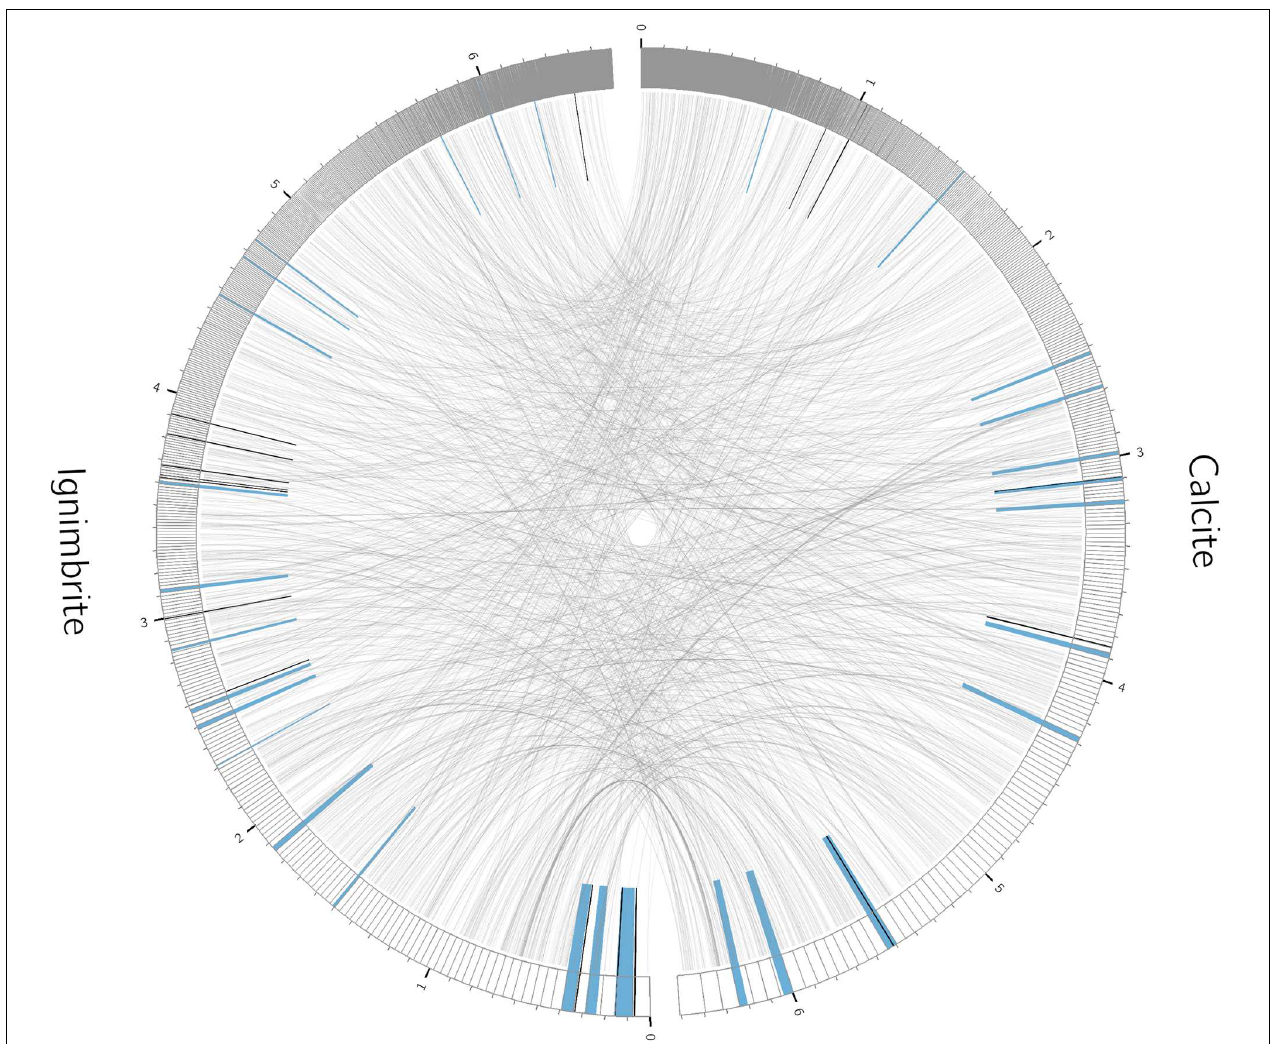
FIGURE 7 | Relationships between contigs from the calcite Ca09 and ignimbrite Ig12 draft genomes. Links are between gene products with greater than 80% amino acid identity. Highlighted in blue are secondary metabolite clusters identified by antiSMASH, and marked in black are Ferrichrome-iron receptor proteins. Figure produced with Circos (Krzywinski et al.,